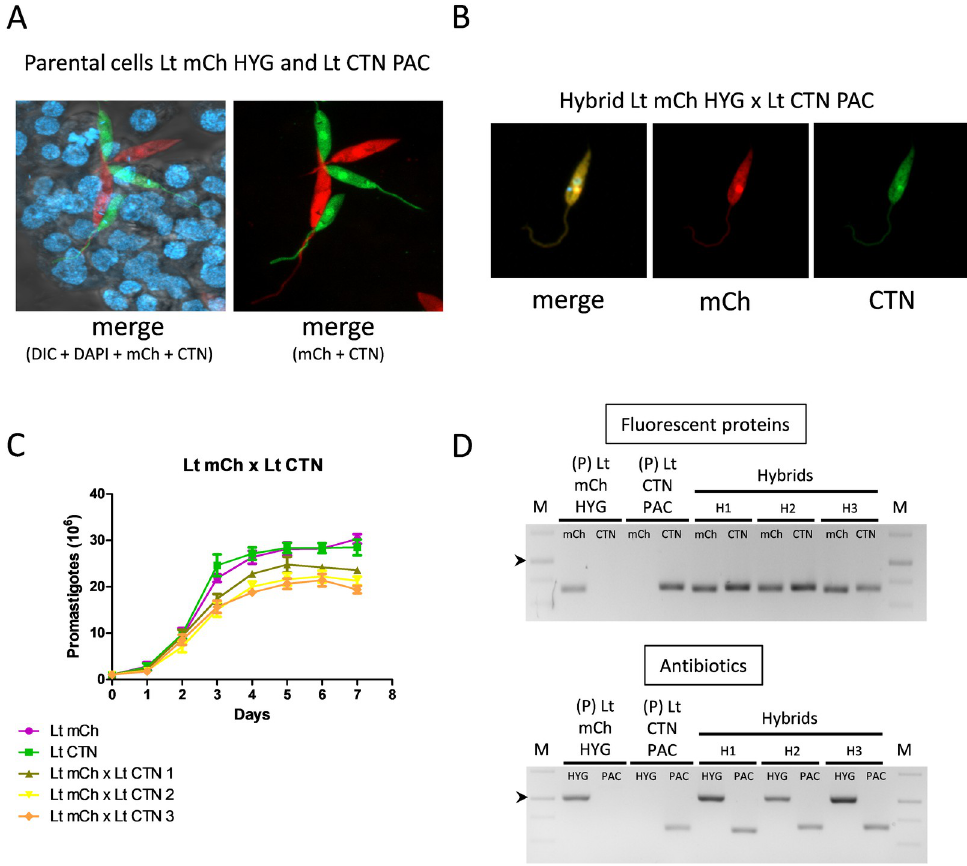
Fig 2. Characterization of intraclonal hybrids. (A) Confocal microscopy showing the interaction between LULO cells and parental cell lines of L . tropica before mating. (B) Representative image of confocal microscopy of one hybrid clon of L . tropica mCh HYG x L . tropica CTN PAC and fluorescence emission in the mCh (561 nm) and CTN (488 nm) channels. (C) Growth curves (number of promastigotes in culture during 7 days) of the parental L . tropica mCh HYG (Lt mCh) and L . tropica CTN PAC (Lt CTN), and three representative intraclonal hybrids (Lt mCh x Lt CTN 1, 2 and 3). (D) Agarose gels of the electrophoresis of the PCR products obtained after the amplification of the genes encoding fluorescent proteins (mCh and CTN) and antibiotic resistance (HYG or PAC) in the parental (P) and three representative intraclonal hybrids (H). The arrowheads indicate the 1000 bp band in the DNA molecular weight marker (M).